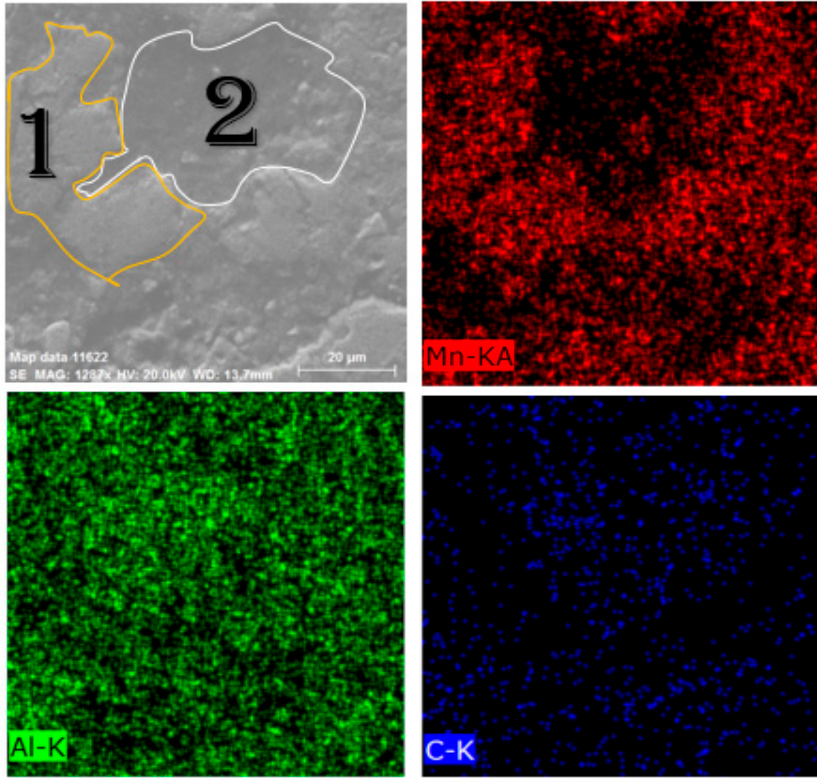
Figure 4. Morphology and mapping images of milled sample in the cylindrical container.